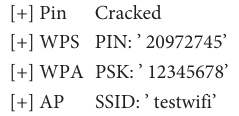
Figure 8: Reaver crack results.